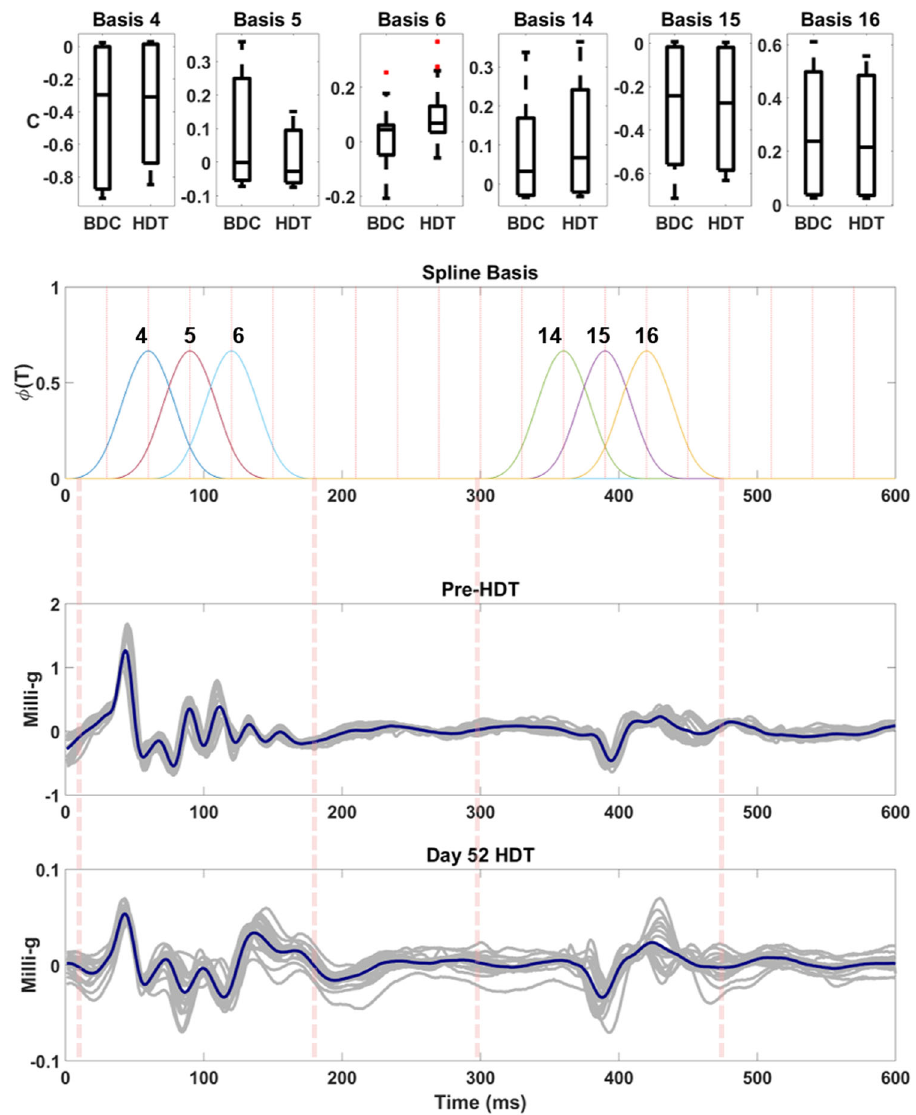
Fig. 3 FDA analysis of SCG signals containing AO and AC basis function coef fi cient sets pre- and post-HDT. Average AO and AC peak decrease over 20 cardiac cycles after 52 days head-down tilt bed rest compared to pre-HDT. Morphology spline coef fi cient sets corresponding to the AO (sets 4, 5 and 6) and AC (sets 14, 15, and 16) peak complexes show distributions from pre-HDT to day 52 HDT furthering the peak changes. Coef fi cient sets de fi ne the spline basis functions shown to describe the SCG signal morphology. Boxes represent ±1 interquartile range, whiskers represent ± 1.5 interquartile range and center lines are